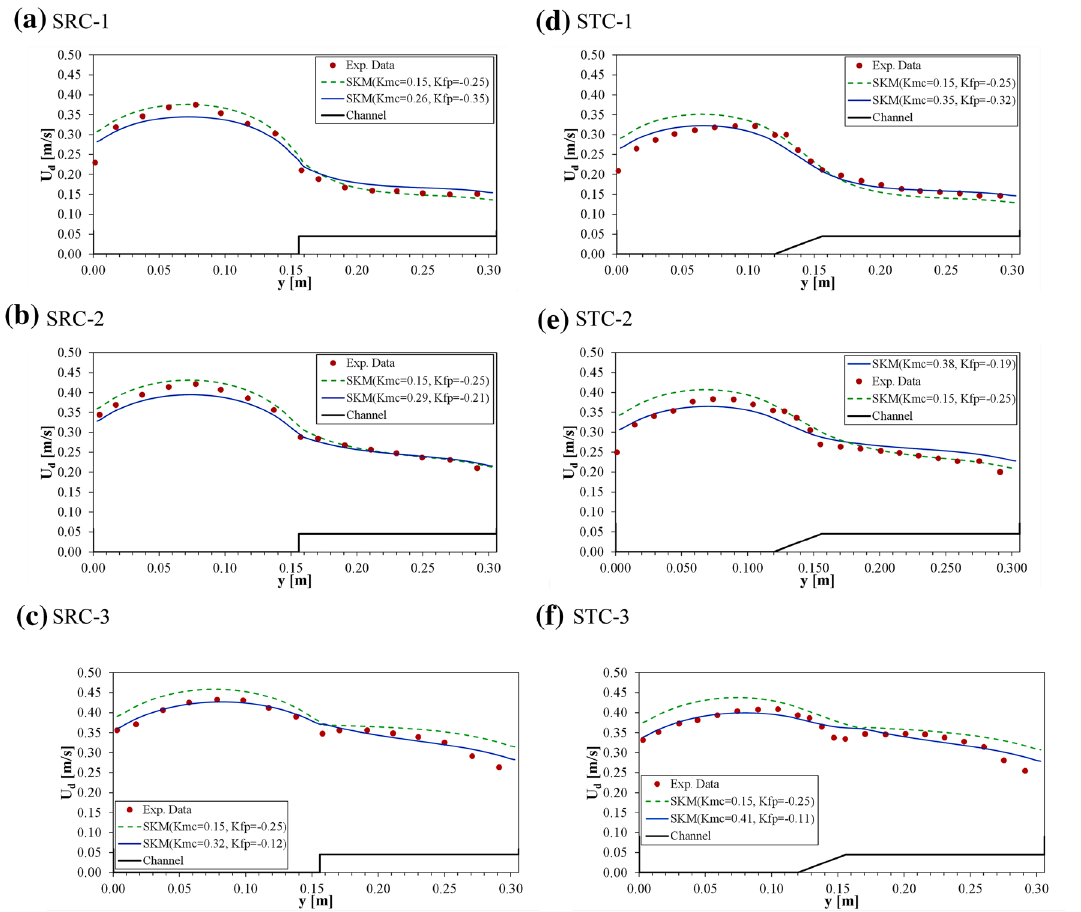
Fig. 2 Results of velocity simulations for small-scale compound channels (the solid line: k calibrated by Devi and Khatua approach, the dashed line: k assumed as Abril and Knight approach)